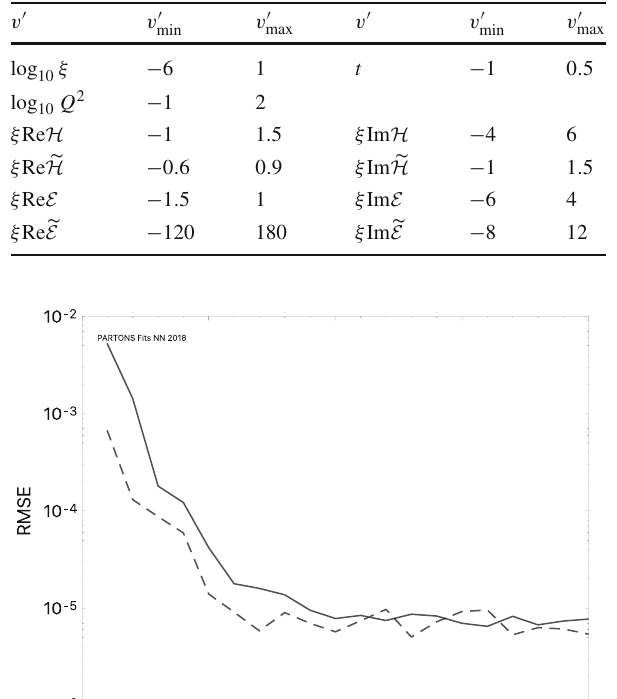
Table 1 Values used in the scaling of input and output variables